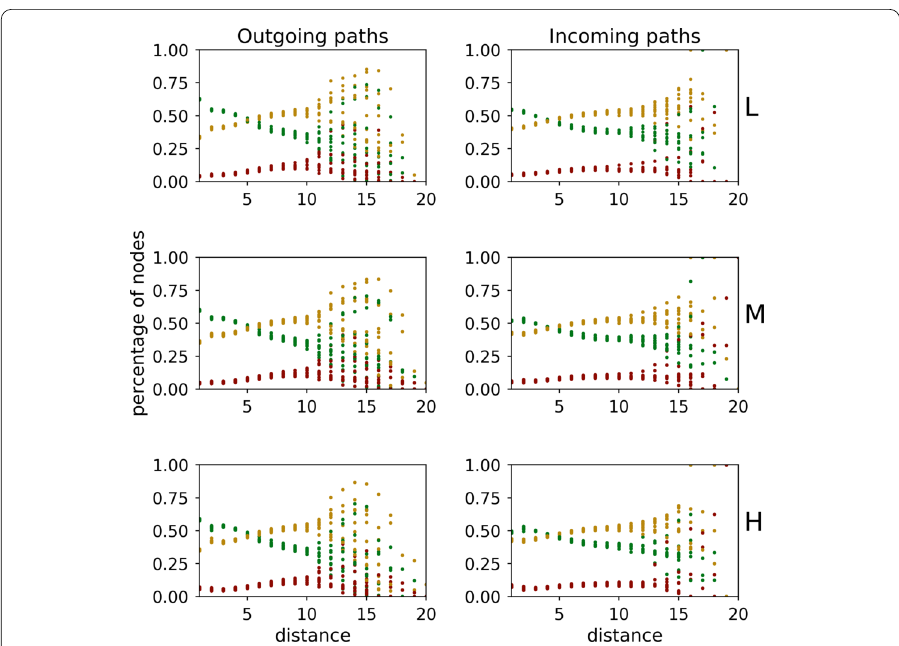
Figure 9 Distribution of ratings for nodes at distance k from (left panels) and to (right panels) nodes with rating L (top panels), M (middle panels), H (bottom panels)